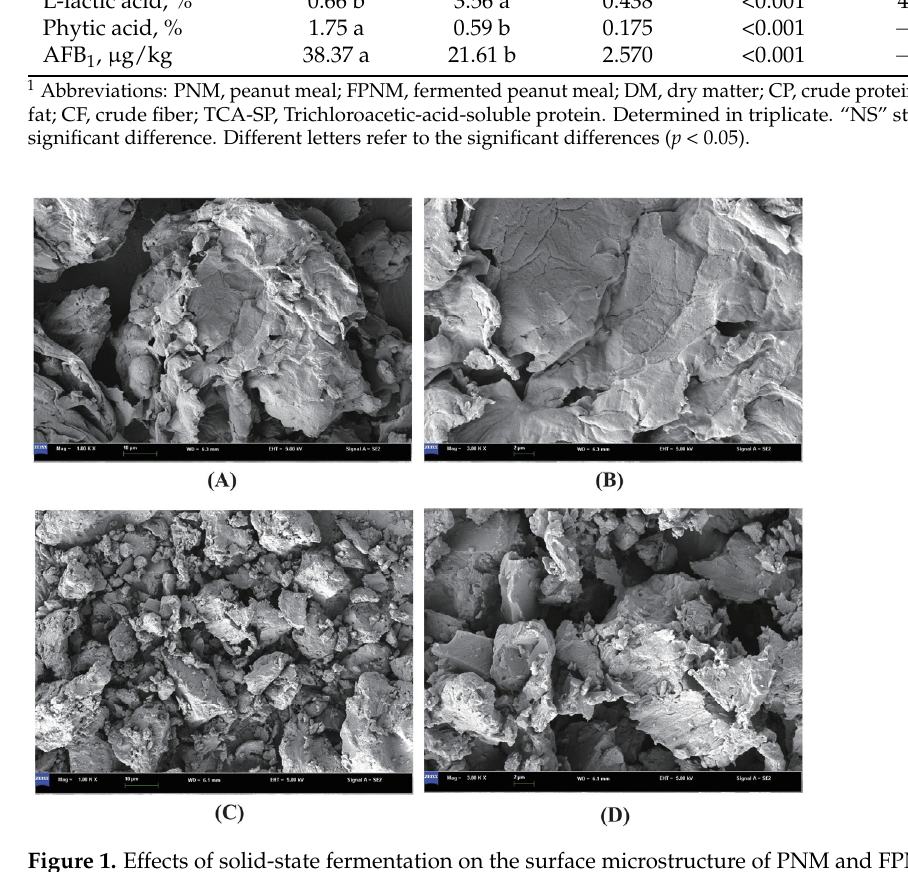
Figure 1. Effects of solid-state fermentation on the surface microstructure of PNM and FPNM. ( A , B ), scanning electron microscopy images of PNM (1000 × & 3000 × ); ( C , D ), scanning electron microscopy images of FPNM (1000× & 3000×).